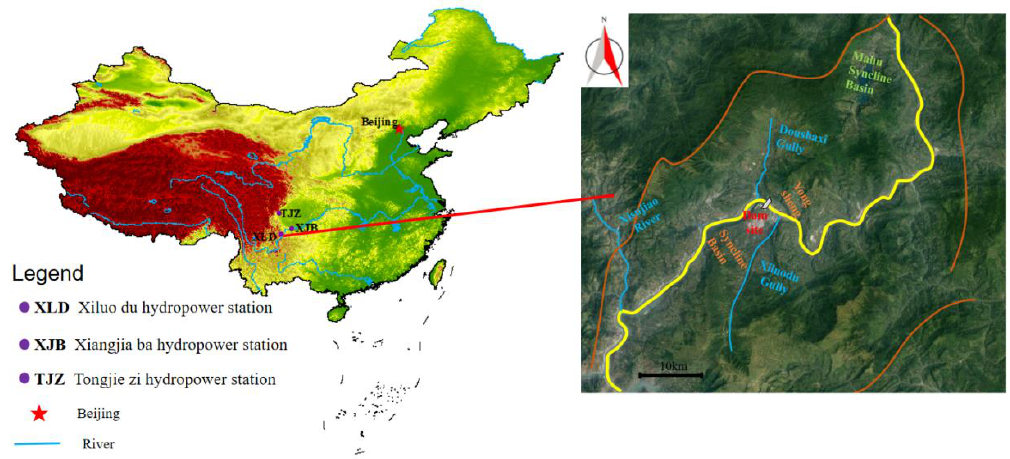
Figure 3. Map showing the geographic location of the study area.